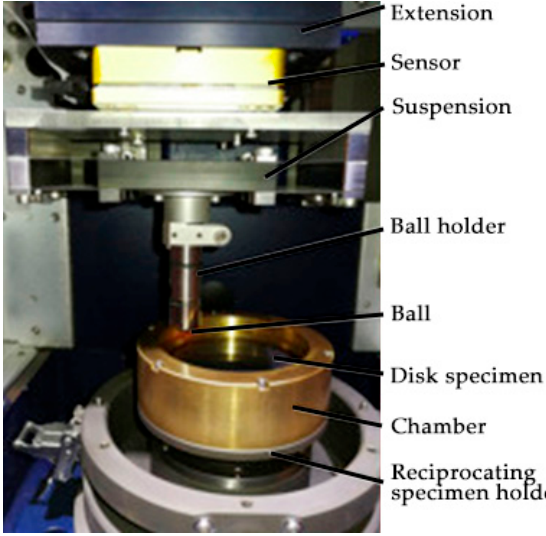
Figure 3. Set-up of rotary drive UMT TriboLab during experiments.